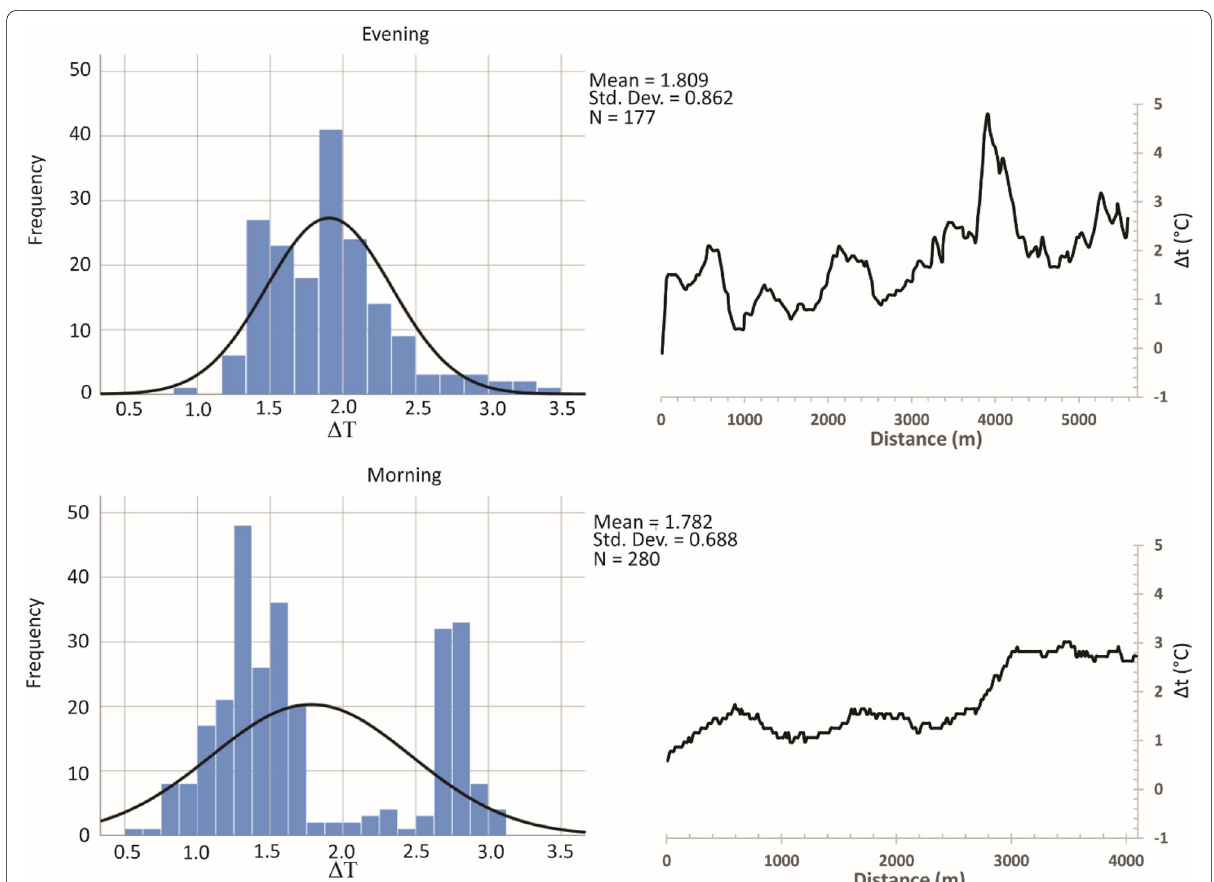
Fig. 10 Histograms of NST record and the corresponding traverse profile for the first in situ traverse walk (8 th January 2018) (top panel) and the second in situ traverse walk (18 th February 2021) (bottom panel) respectively. The late afternoon traverse (8 th January 2018) showed a greater variability in ΔT values that followed a relatively normal distribution than the evening traverse (18 th February 2021)